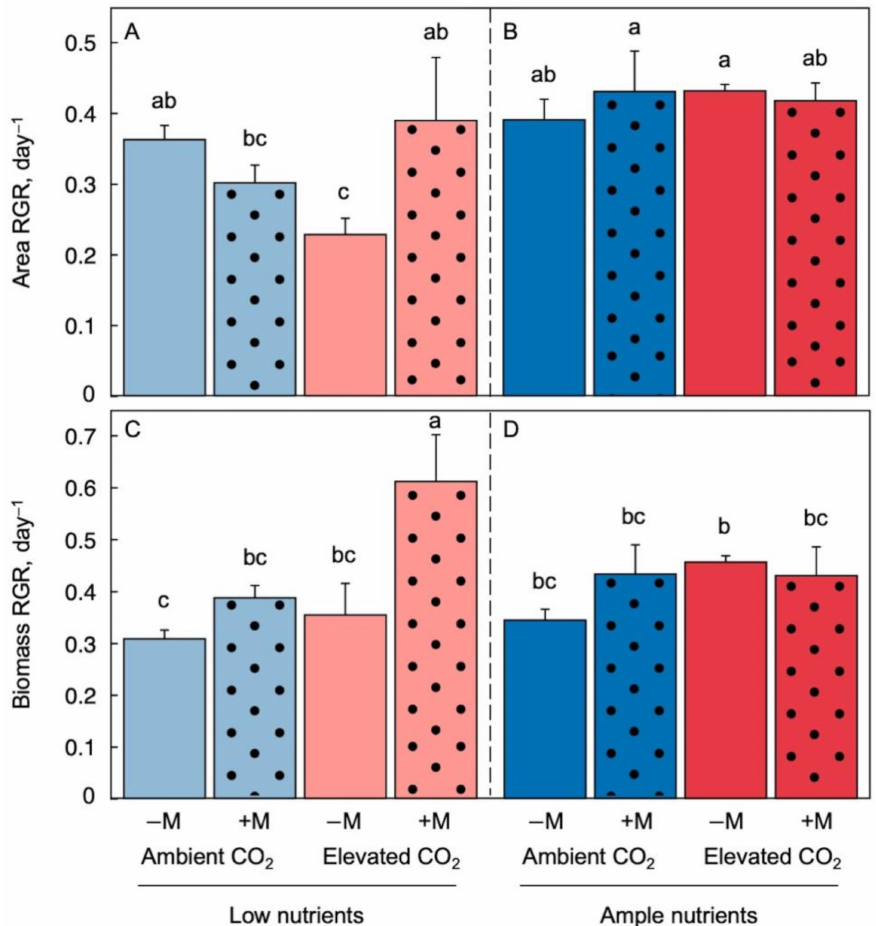
Figure 2. Relative growth rate (RGR) of frond area expansion under low ( A ) and ample ( B ) nutrients as well as rate (RGR) of biomass production under low ( C ) and ample ( D ) nutrients for Lemna minor grown in 1/20 (light blue or light red) or 1/2 (dark blue or red) strength Schenk & Hildebrandt medium under either ambient (blue) or elevated (red) CO 2 levels. Blue vs. red colored bars correspond to ambient versus elevated CO 2 conditions, respectively. Bars with solid fill represent groups that were not inoculated ( − M) compared to bars with dotted fill that were inoculated (+M). Mean values ± standard deviations; n = 3. Different lower-case letters represent significant differences at p <